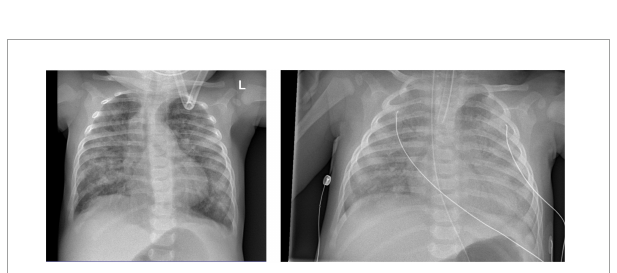
FIGURE4 Chest X-ray of patient six at 4 months of age shows lung infiltrations and development of acute respiratory distress syndrome (ARDS, pneumocystis carinii and streptococcus pneumonia).